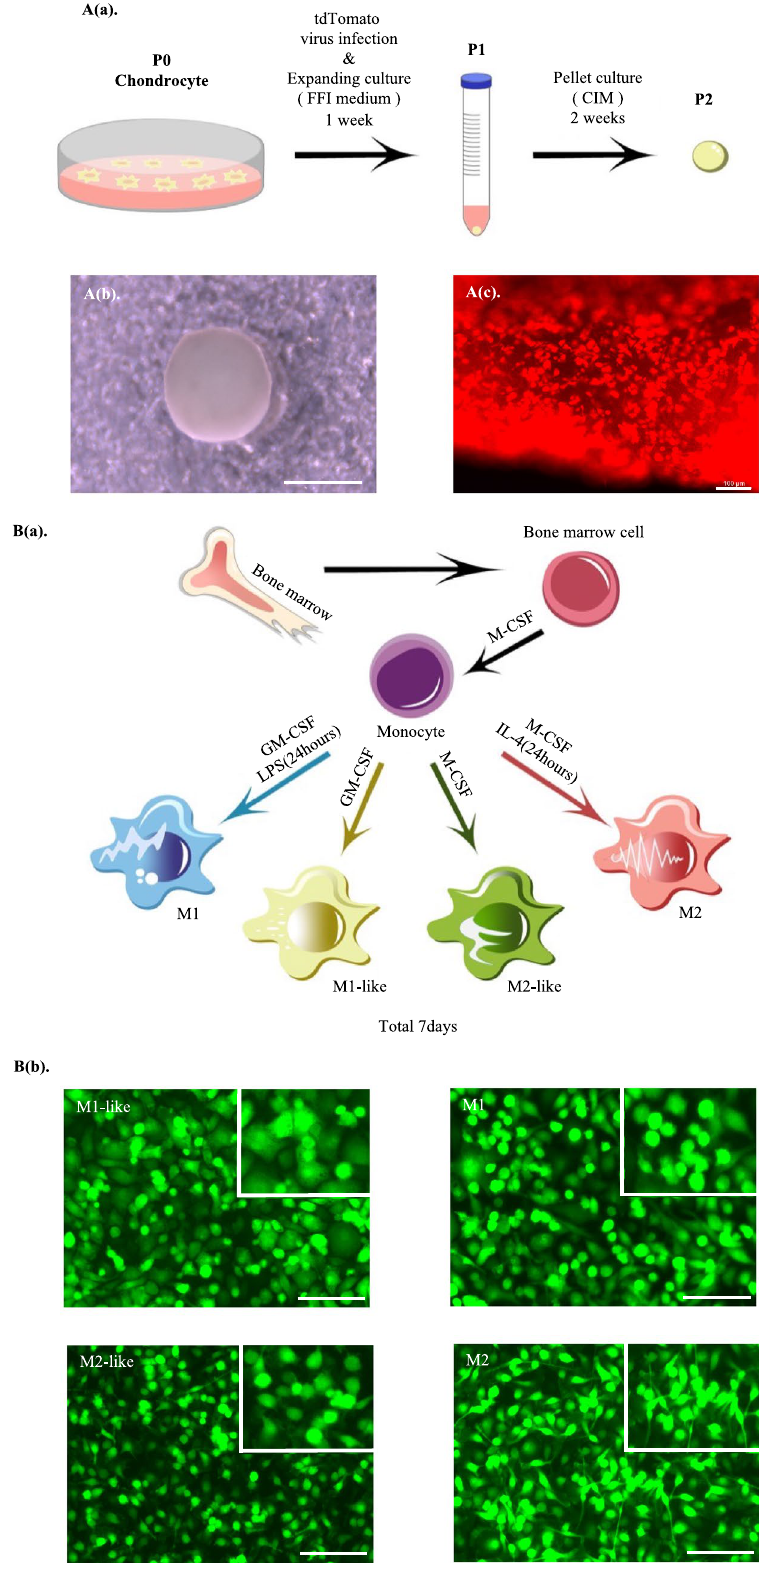
Figure 1. Establishment of co-culture system for cartilage pellets and macrophages. ( A ( a )) Cartilage pellet culturing method. ( A ( b )) Whole image of a cartilage pellet. Scale bar: 1 mm. ( A ( c )) Fluorescence microscopy findings of cartilage pellet. Magnification: 100 × , Scale bar: 100 μm. ( B ( a )) Macrophage differentiation culturing method. ( B ( b )) Fluorescence microscopy findings of macrophages. Magnification: 100 × . Scale bars: 100 μm. ( B ( c )) Cytokine gene expression in macrophages after induction of differentiation (day 0). *P < 0.05, **P < 0.01, ***P < 0.0001. The data are shown as the mean ± SEM (n = 3). ( C ) Co-culture system of cartilage pellets and